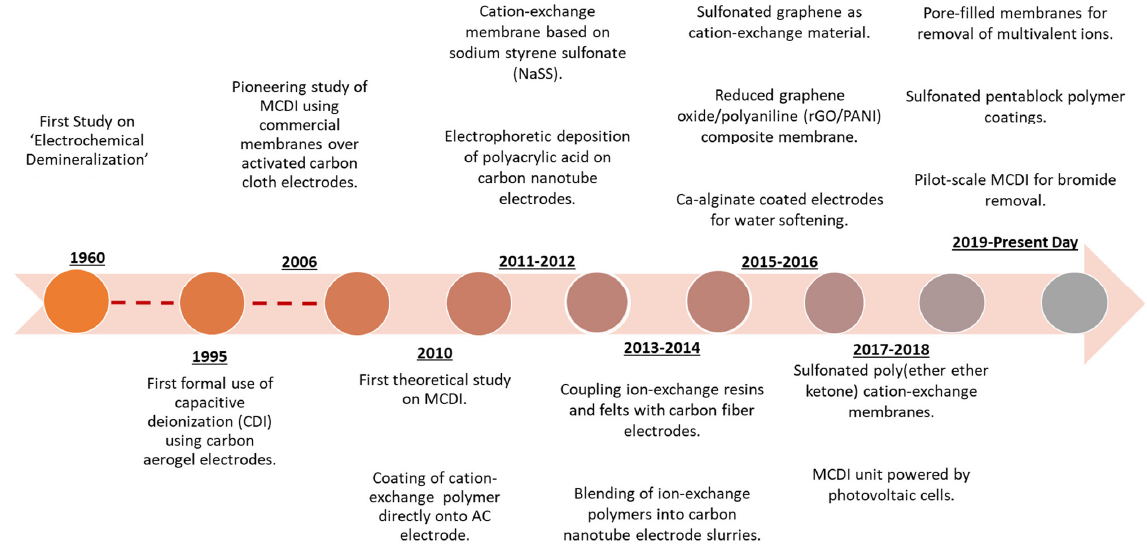
Figure 3. Timeline displaying selected key developments and advances of ion-exchange materials for MCDI. Reproduced from [50], used under CC-BY 4.0.